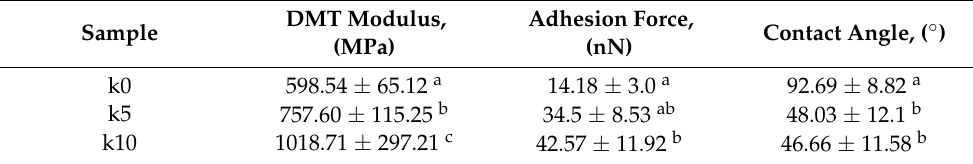
Table 1. The mean values of the measured surface parameters for 3 areas for each sample.